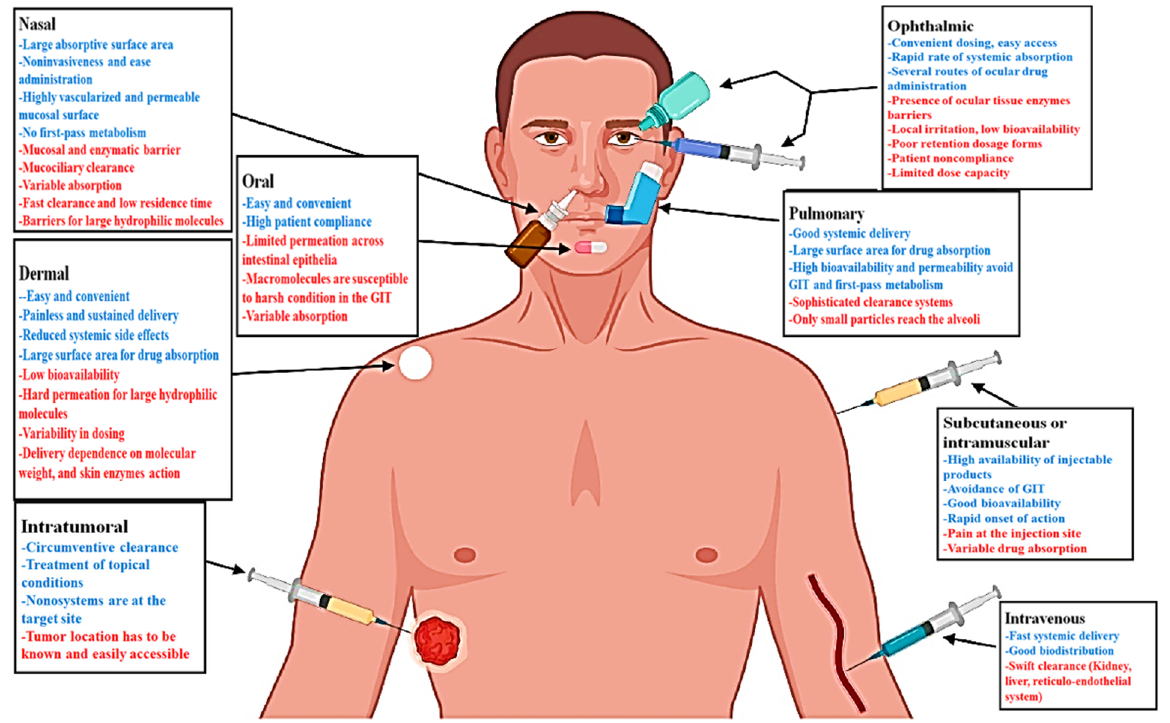
Figure 1. Schematic illustration of the routes generally used for MSN administration, including their main advantages (blue) and challenges (red). Reproduced with permission from ref [41]. Copyright 2021